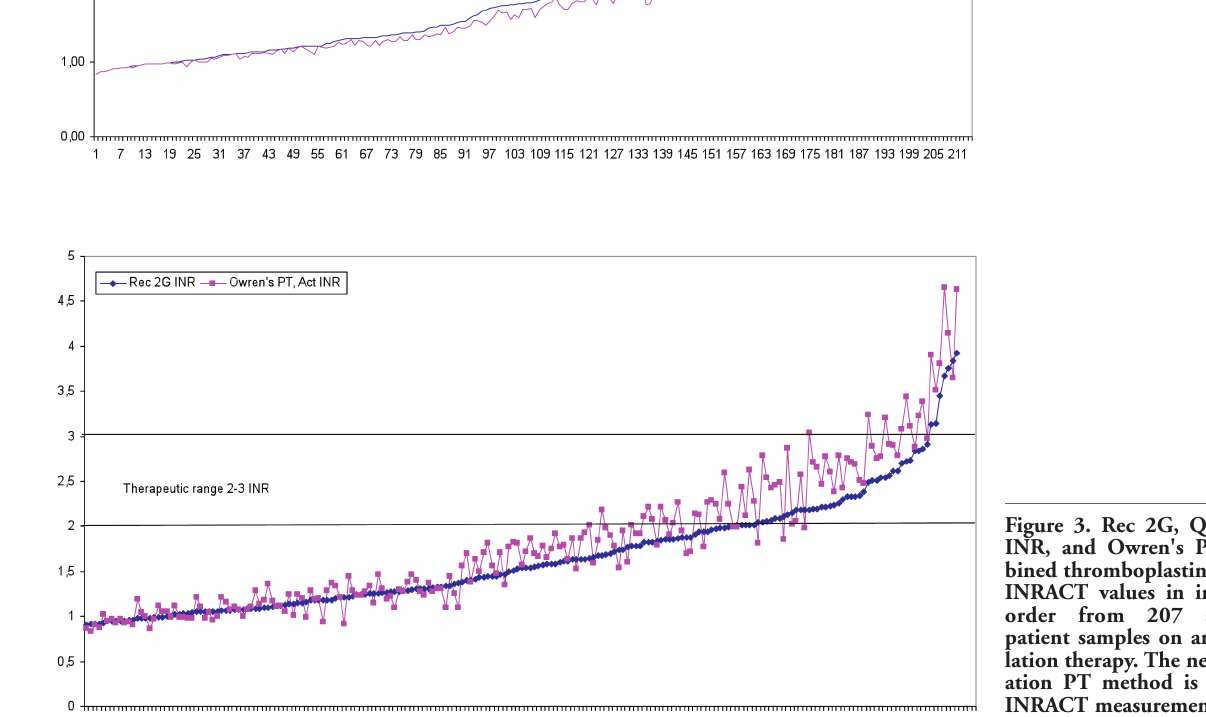
Figure 3. Rec 2G, Quick PT, INR, and Owren's PT (com- bined thromboplastin reagent) INRACT values in increasing order from 207 analyzed patient samples on anticoagu- lation therapy. The new-gener- ation PT method is used for INRACT